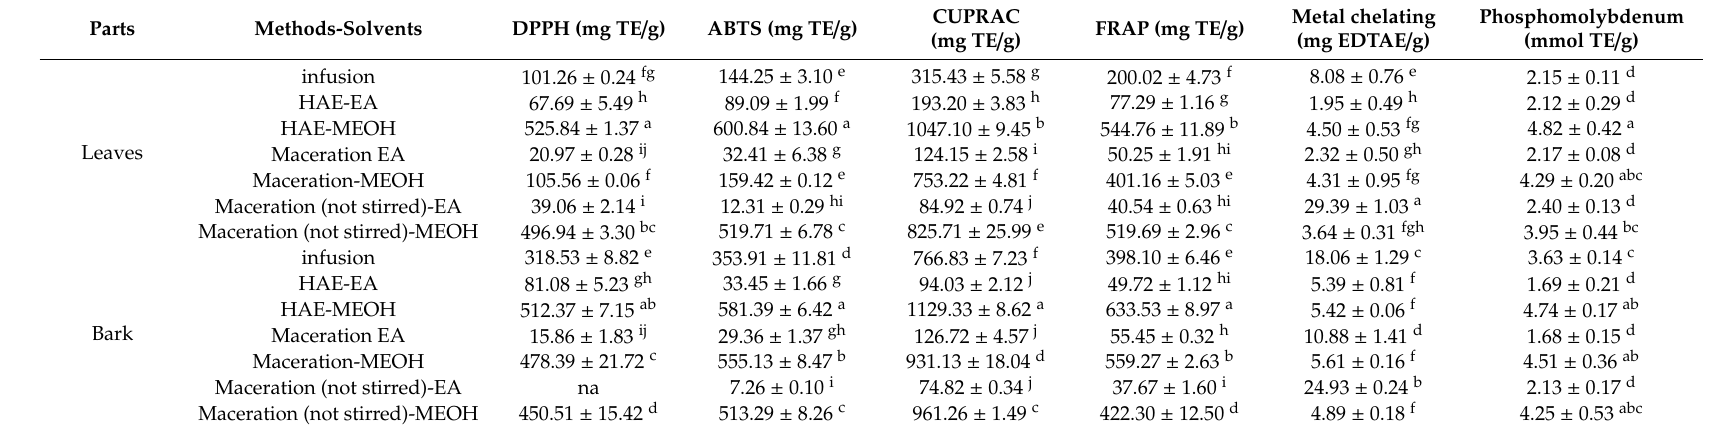
Table 3. Antioxidant properties of the tested extracts